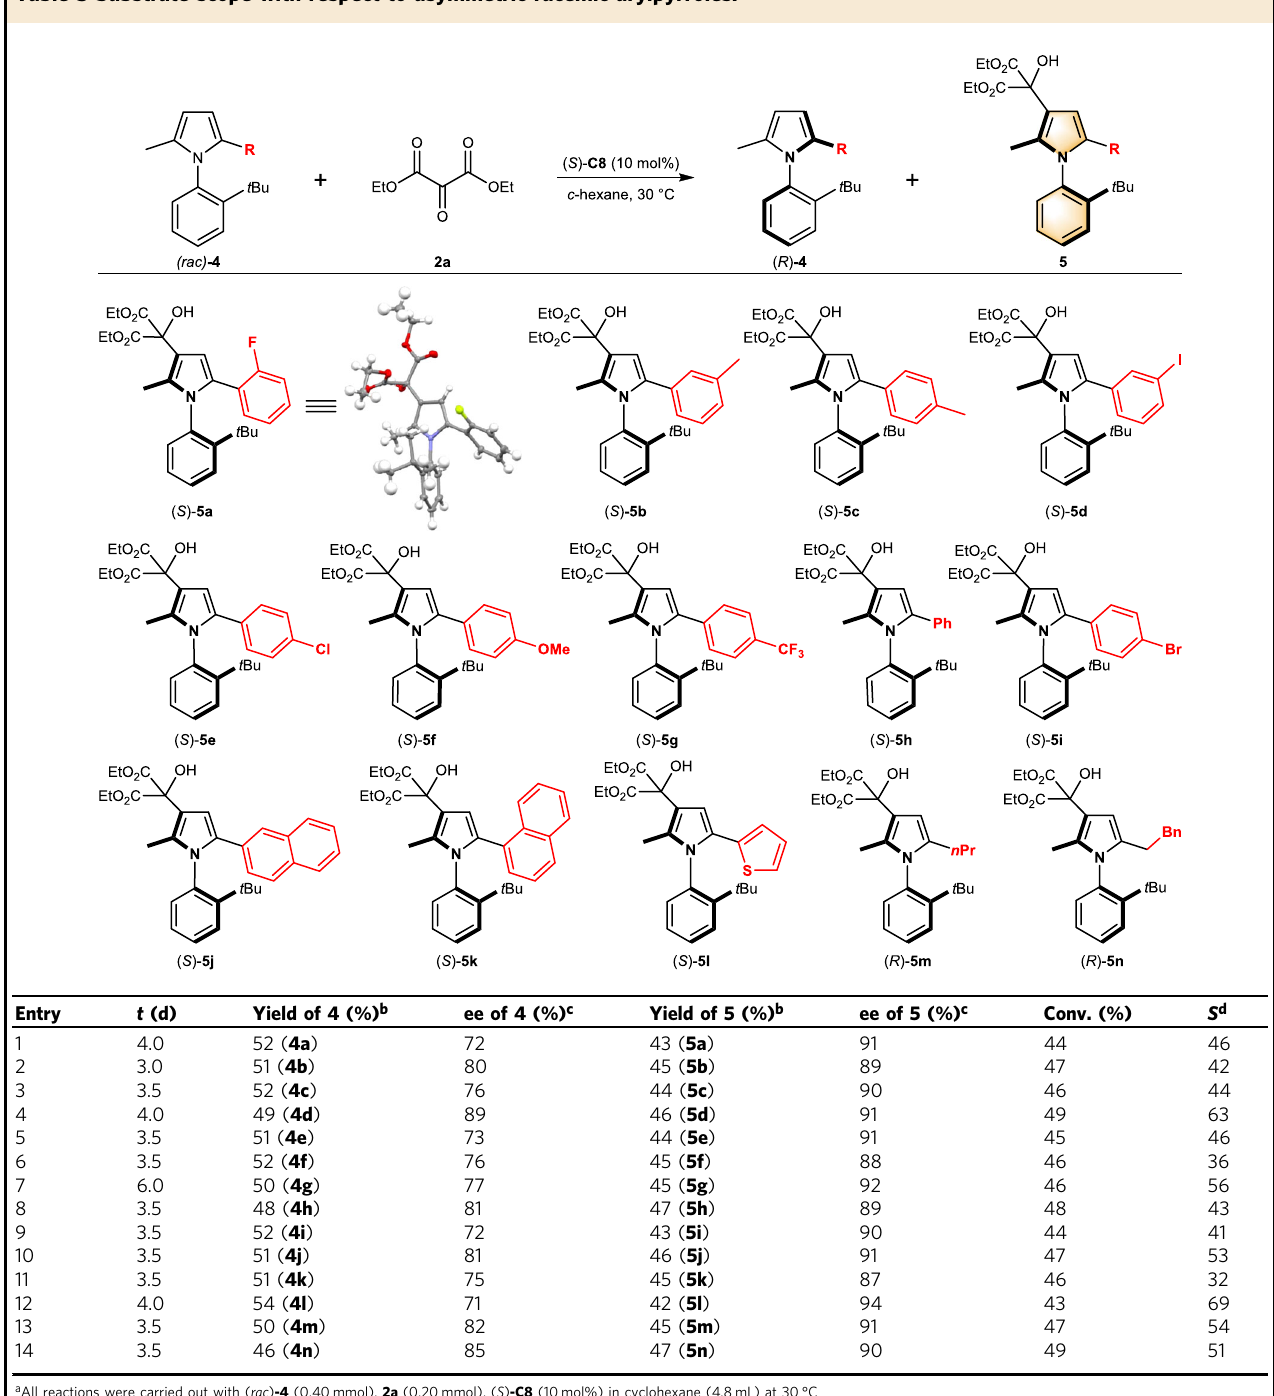
Table 3 Substrate scope with respect to asymmetric racemic arylpyrroles.